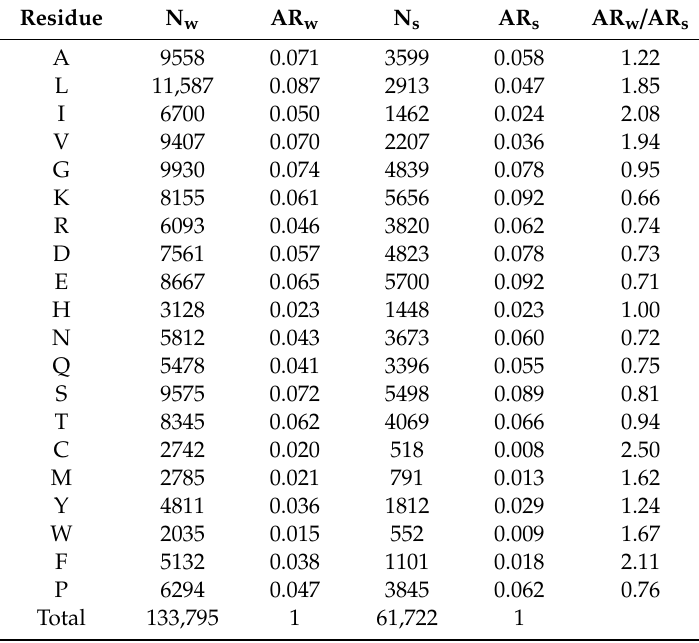
Table 1. Number and abundance of whole protein and surface